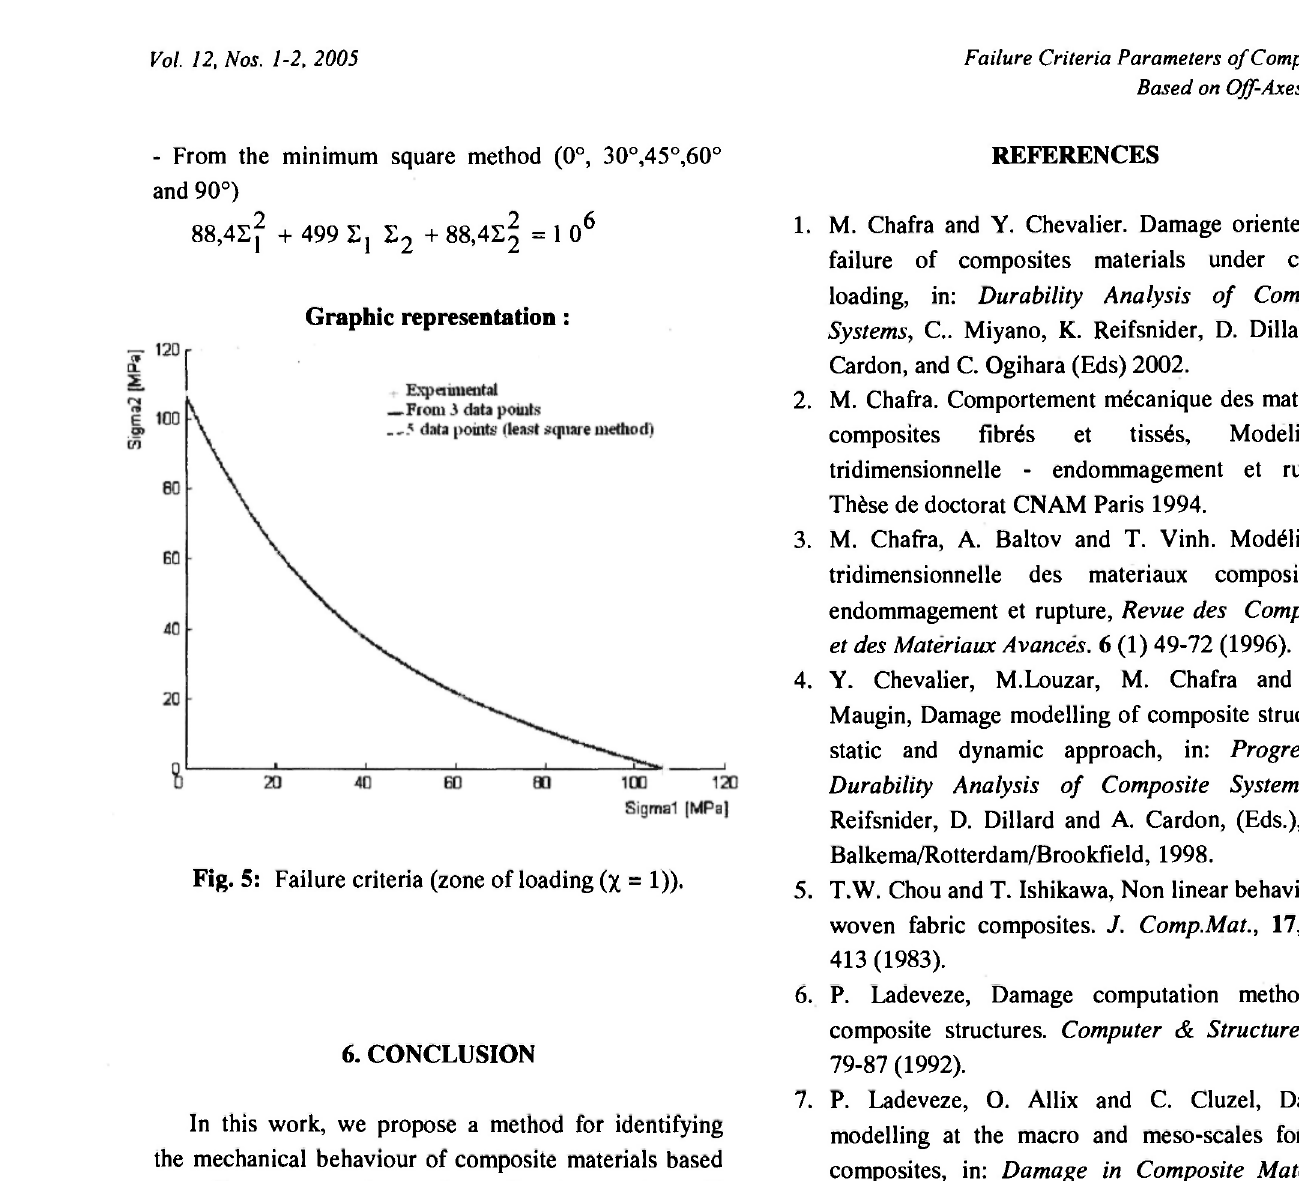
Fig. 5: Failure criteria (zone of loading (χ =